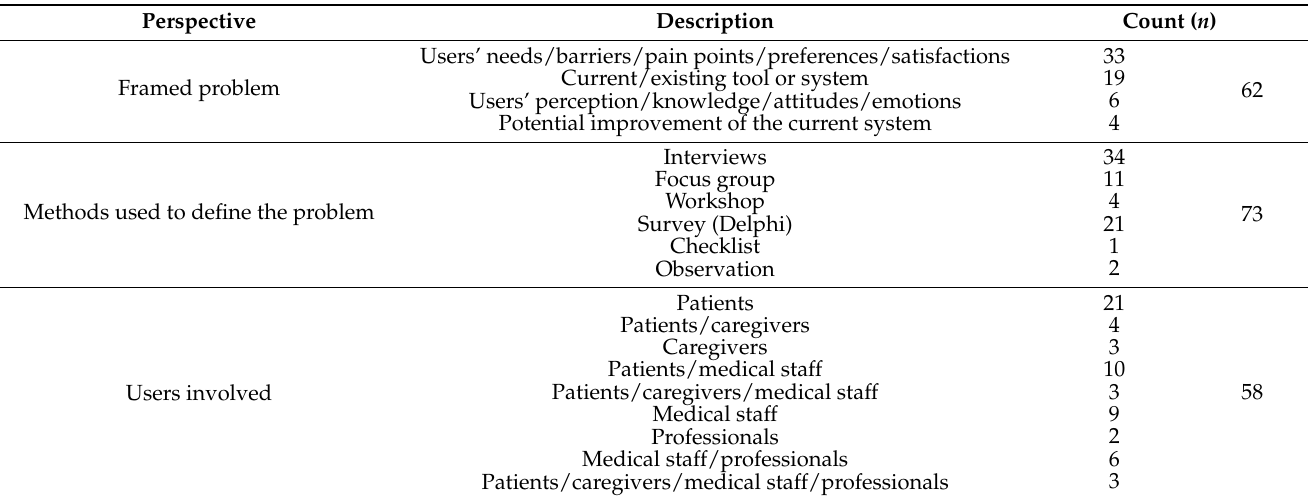
Table 7. Summary of study’s